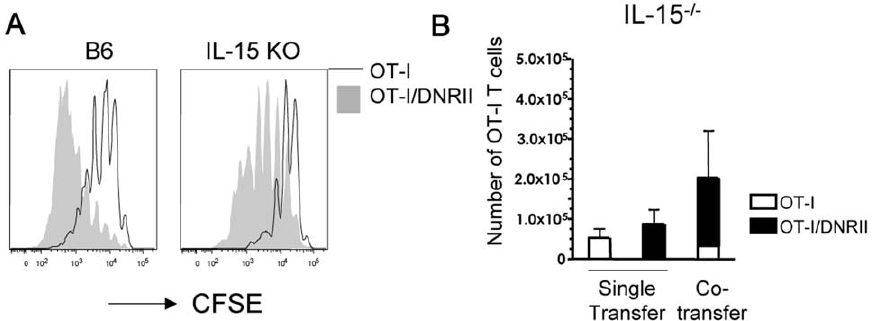
Figure 3. IL-15 is not required for the enhanced homeostatic proliferation of OT-I/DNRII CD8 T cells. CFSE labeled CD44 lo OT-I and OT-I/ DNRII CD8 T cells were adoptively transferred into sublethally irradiated IL-15 2 / 2 hosts. Host animals were sacrificed and donor cells were analyzed. ( A ) CFSE dilution of OT-I and OT-I/DNRII CD8 T cells in the spleen 3 weeks after co-transfer into sub-lethally irradiated B6 and IL-15 KO hosts (n=3). ( B ) Recovery of OT-I and OT-I/DNRII CD8 T cells 18 days after single or co-transfer in the lymph nodes (n=3). Data are representative of at least 3 independent experiments.